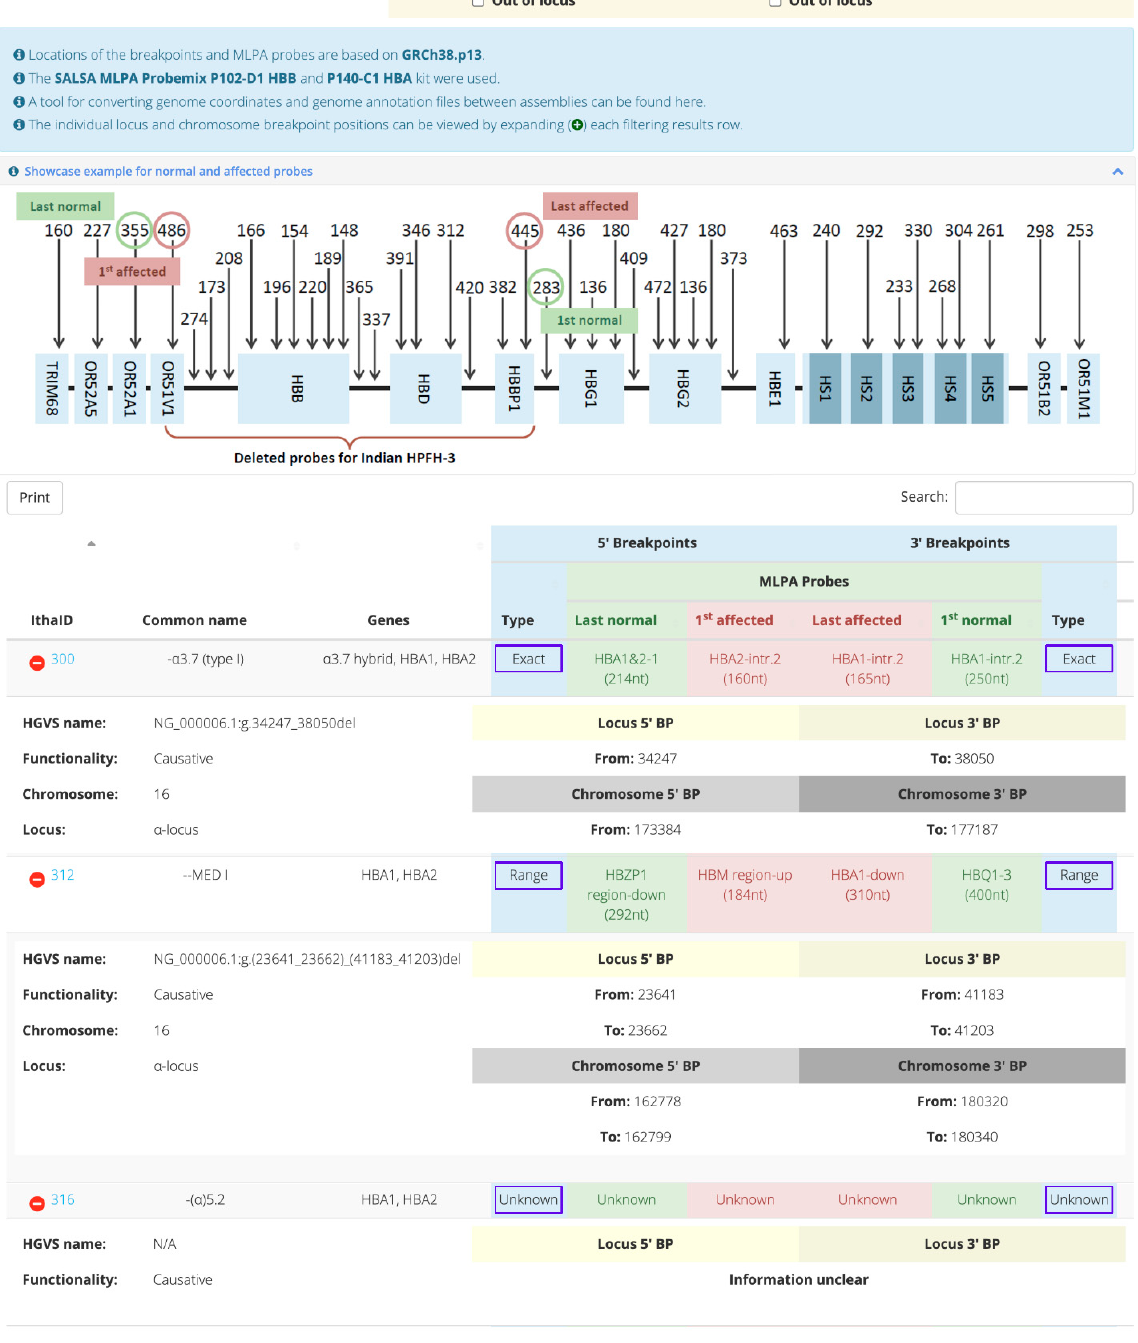
Figure 1. Home page of the IthaCNVs tool. Filtering is based on the CNV location.